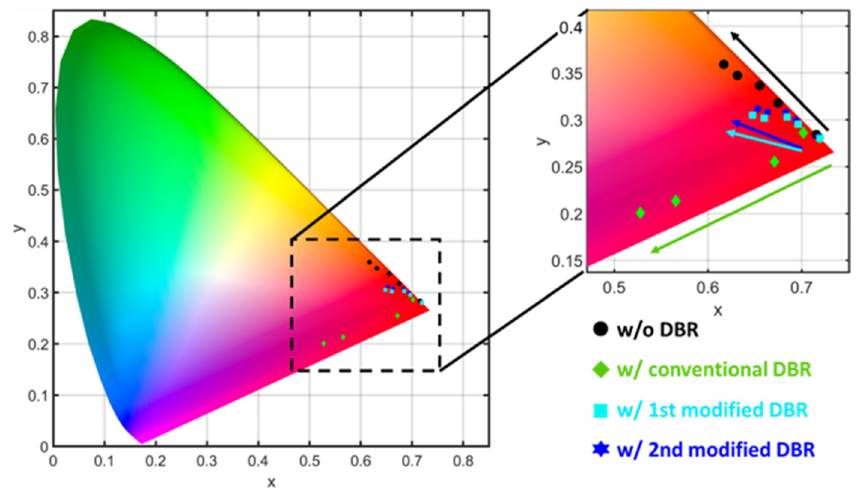
Figure 6. The CIE 1931 color space for the InGaN red micro-LEDs with different DBRs. At the current density of 32 A/cm 2 , the coordinates for different designs are all around (0.71, 0.28) in the CIE color space. While the current density increased to 400 A/cm 2 , the color become amber and magenta for the InGaN red micro-LEDs without and with con- ventional DBR. In contrast, the colors for the ones with modified DBRs are not significantly changed. To further identify the color difference between both modified DBR designs, the 8-bit encoded RGB values were calculated and listed in Table 1 [56,57]. Table 1. The calculated x, y value in the CIE 1931 color space and the corresponding RGB color code for the InGaN red micro-LED with different